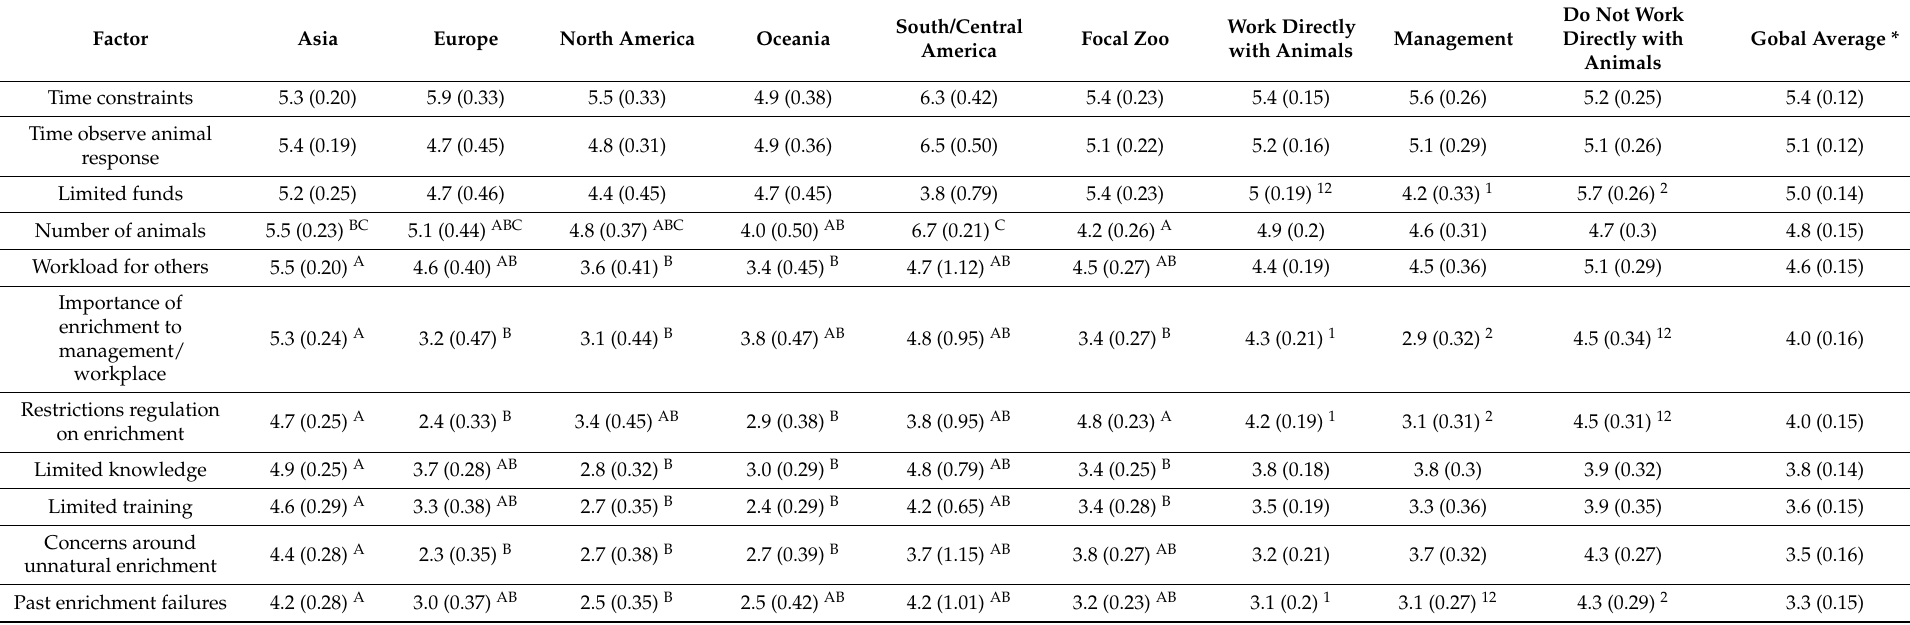
Table 5. Average Likert rating for factors affecting the use of cognitive enrichment within region and job role with standard error in parenthesis. 1 = No effect to 7 = Significant effect. Statistically significant differences in means within factor (e.g., number of animals) are indicated with alphanumerical superscripts. Regions, alphabetical (A, B, C) and or work role, numerical (1,